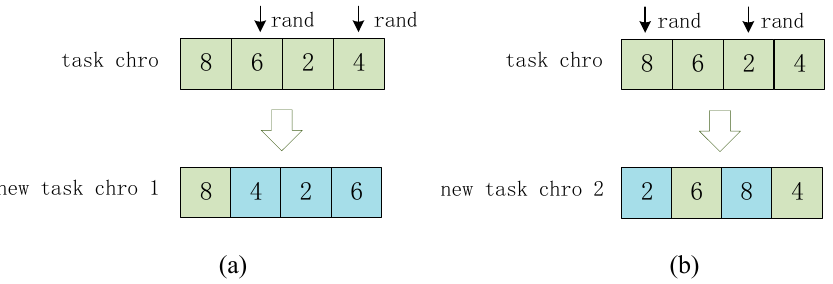
Figure 8. Task chromosome mutation: ( a ) inversion mutation and ( b ) exchange mutation.